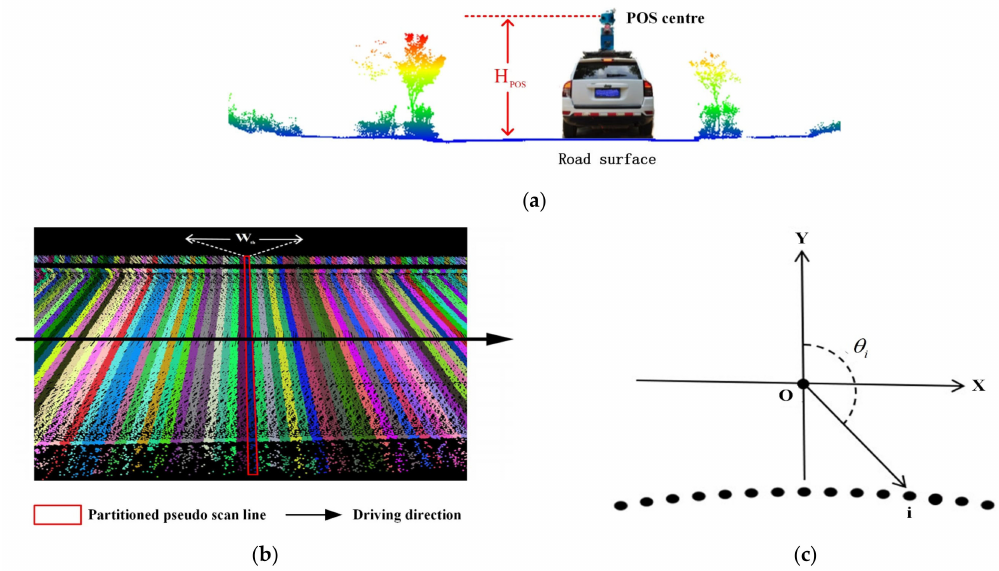
Figure 2. Pre-processing for road surface extraction: ( a ) The POS (positioning and orientation system) height, H POS , from the POS centre to the road surface; ( b ) pseudo-scan lines rendered by random colours; ( c ) local coordinate system of points inside a pseudo-scan line.